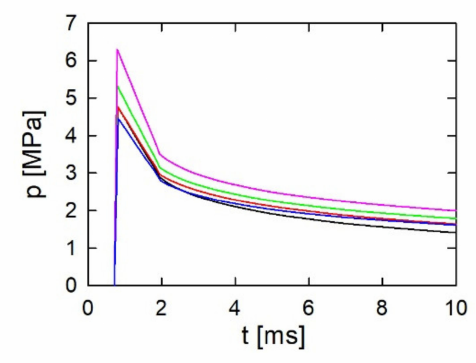
Figure 7. Pressure courses were recorded for the chamber filled with the sleeve.